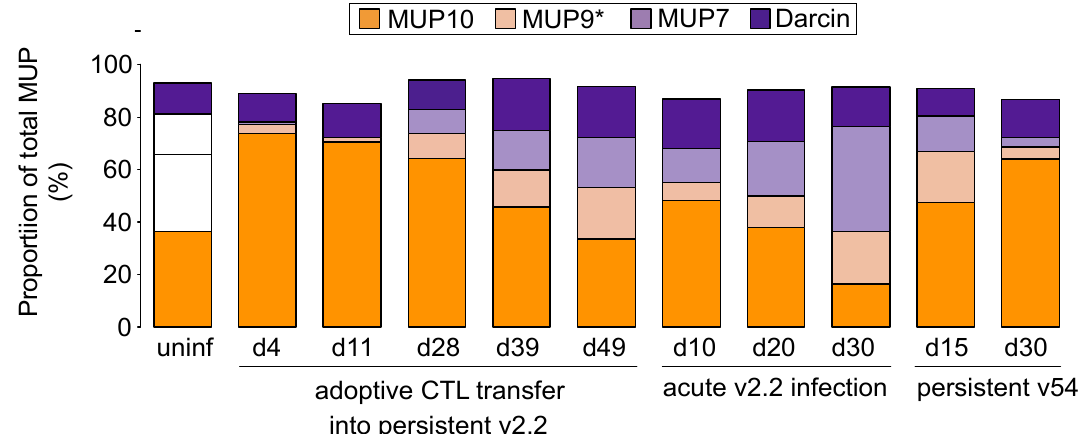
Figure 5. Proportional changes in MUP profile during LCMV infection. The MUP profiles from Figure 4 were expressed in relative terms, with each MUP mass displayed as a percentage of the contribution to total MUP output. Data are means for each treatment group and time point, sample sizes as in Figure 4. Uninfected males were of equivalent age and singly housed.